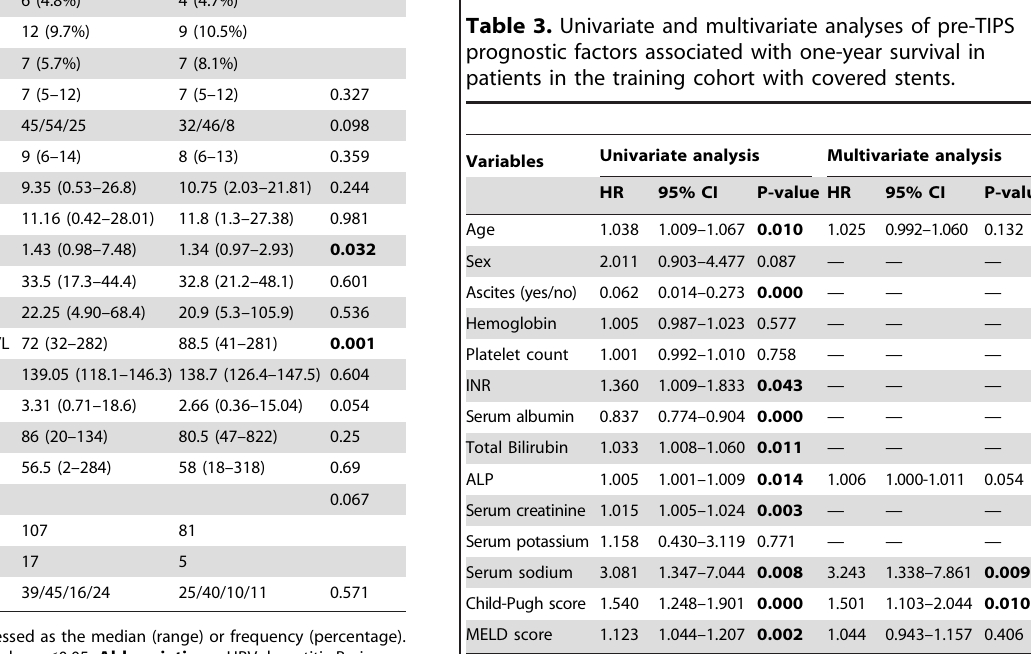
NOTE . Bold values indicate P-values , 0.05; —: not included in the multivariate analysis. Abbreviations : INR, international normalized ratio; ALP, alkaline phosphatase.